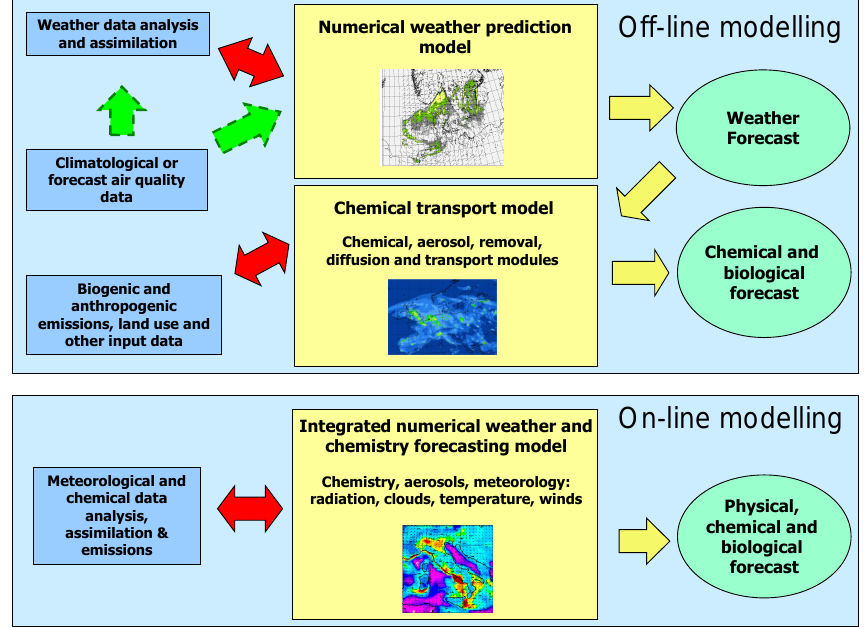
Fig. 1. Schematic diagram of the off-line and on-line coupled NWP and CTM modelling approaches for CWF.